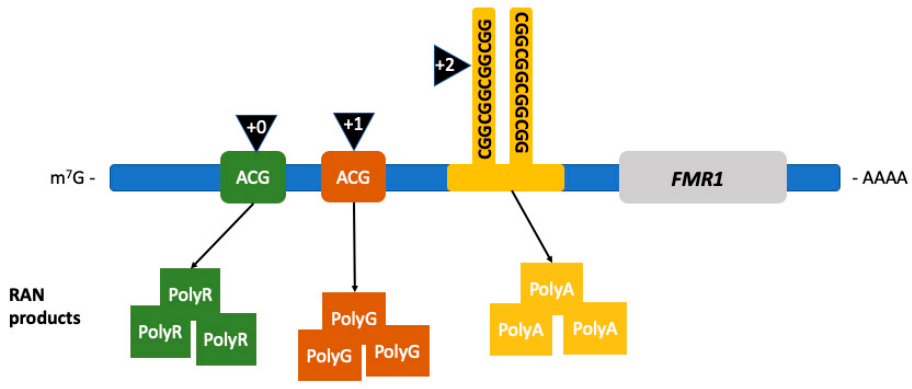
Figure 2. Repeat associated non ‐ AUG (RAN) translation in FXTAS. RAN translation leads to the production of RAN products depending on the location where the initiation of translation occurs. Initiation (black triangles) occurring in the +0 reading frame leads to the production of FMRpolyR (green squares), +1 to FMRpolyG (brown squares), and +2, within the CGG ‐ repeat region, to the production of FMRpolyA (yellow squares). (Adapted from Glineburg et al. 2018) [127].